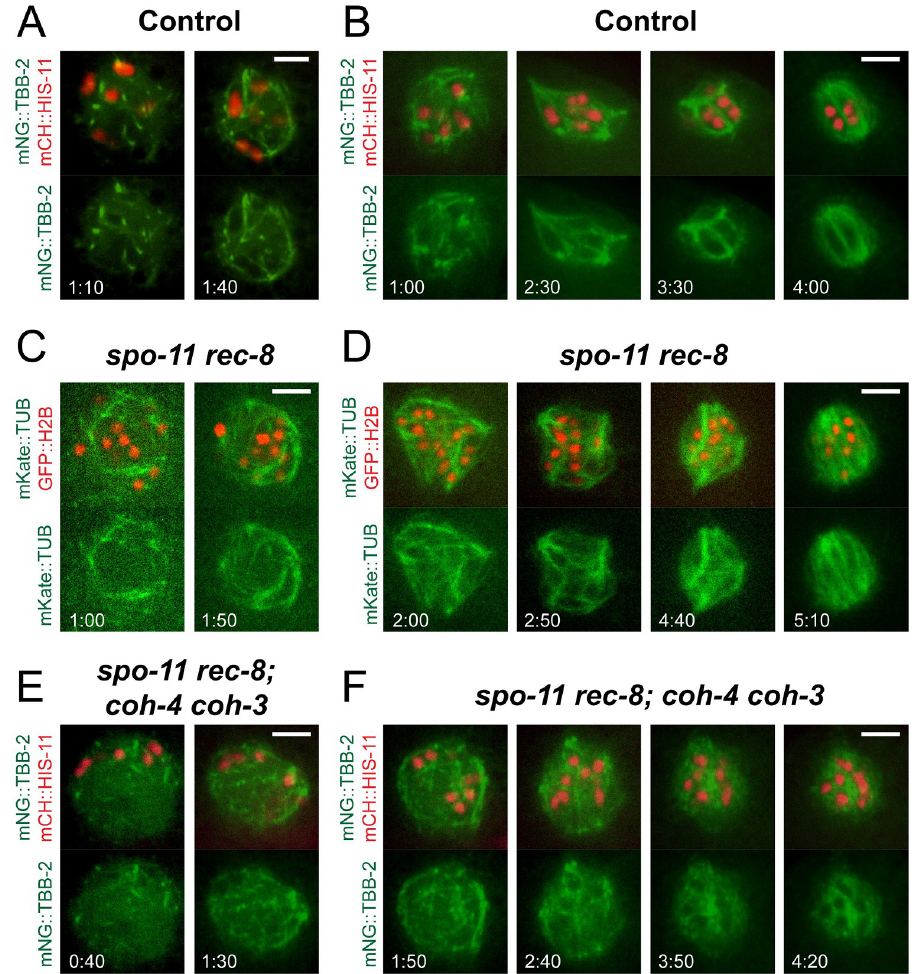
Fig 7. Cohesin is necessary to direct the formation of spindle poles. Time-lapse images in A, C, and E were captured in the gonad prior to ovulation; images in B, D, and F were captured post-ovulation in the uterus. (A, B) Time-lapse images of 7/7 control embryos show MT fibers organizing rapidly around chromosomes. Spindles become multipolar, then bipolar as poles coalesce. Times are from the initial observation of spindle MTs. (C, D) Time-lapse images of 13/ 13 spo-11 rec-8 embryos show spindle fibers coalescing into multiple poles, then two poles. (E, F) Time-lapse images of 7/7 spo-11 rec-8 coh-4 coh-3 embryos show that spindle fibers begin to form, but do not become organized into poles. All bars = 4 μ